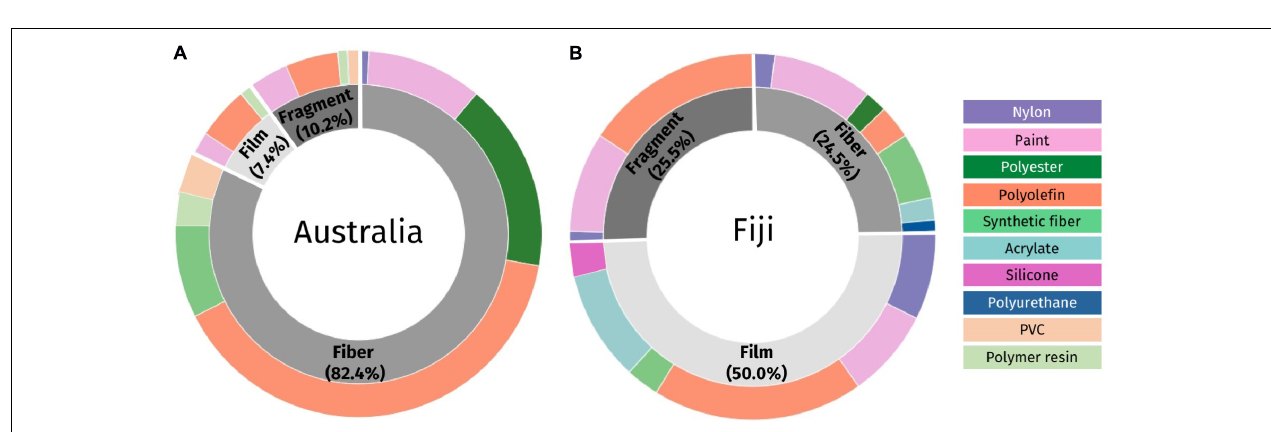
FIGURE 5 | Average plastic load per fish. The points show the expected mean number of microplastics found in the gastrointestinal tract of each species from a negative binomial GLM fitted to the data. The vertical lines represent the lower and upper 95% confidence intervals. The blue points and lines represent fish purchased in Fiji, while the orange points and lines are those purchased in Australia. Table 1 provides scientific species names, where goatfish is yellowspot goatfish for Fiji and bluestriped goatfish for Australia.